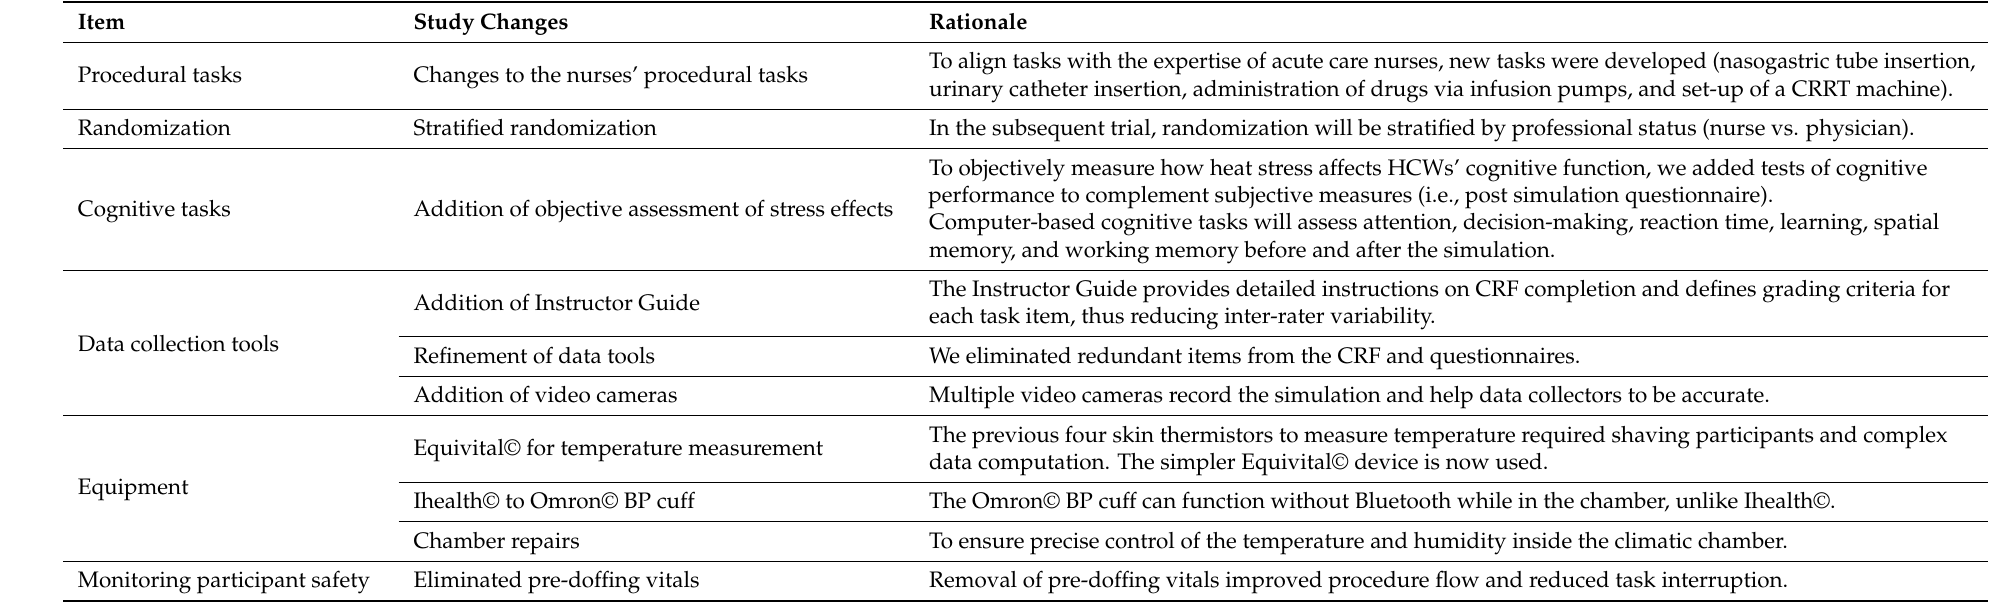
Table 4. Summary of protocol changes based on pilot